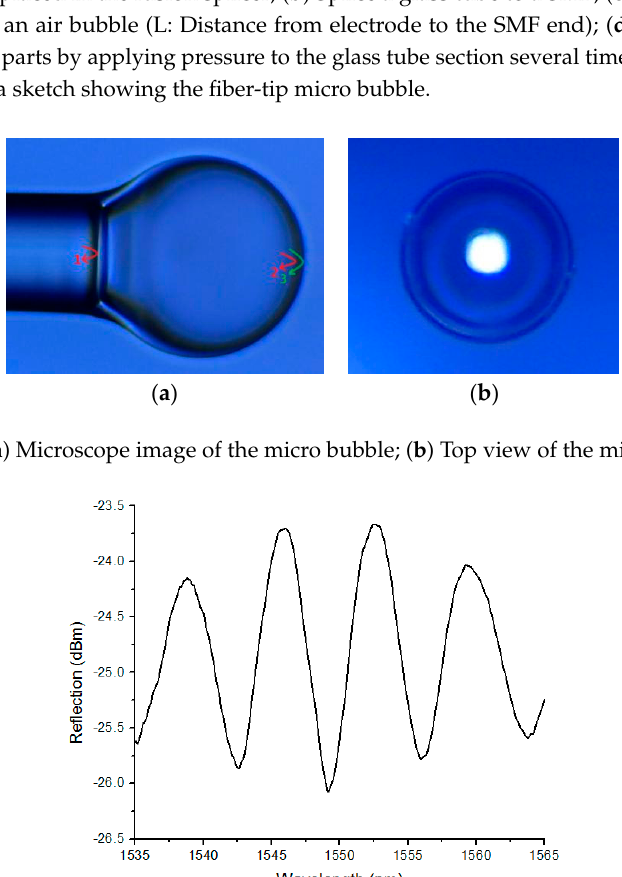
Figure 1. Schematic diagrams of the fabrication process of in-fiber FPI based on an air bubble. ( a ) SMF